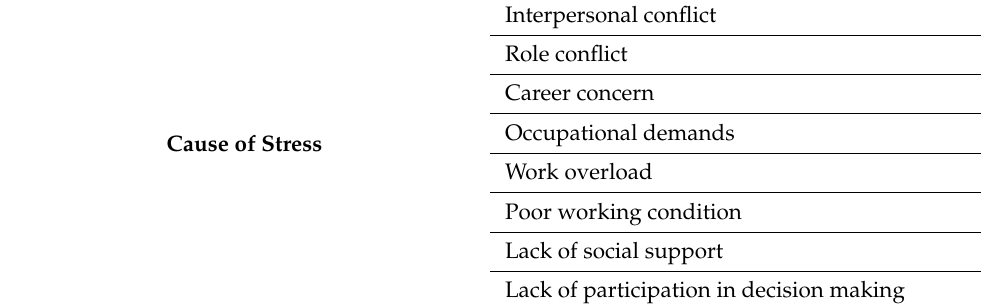
Table 1. Major causes of